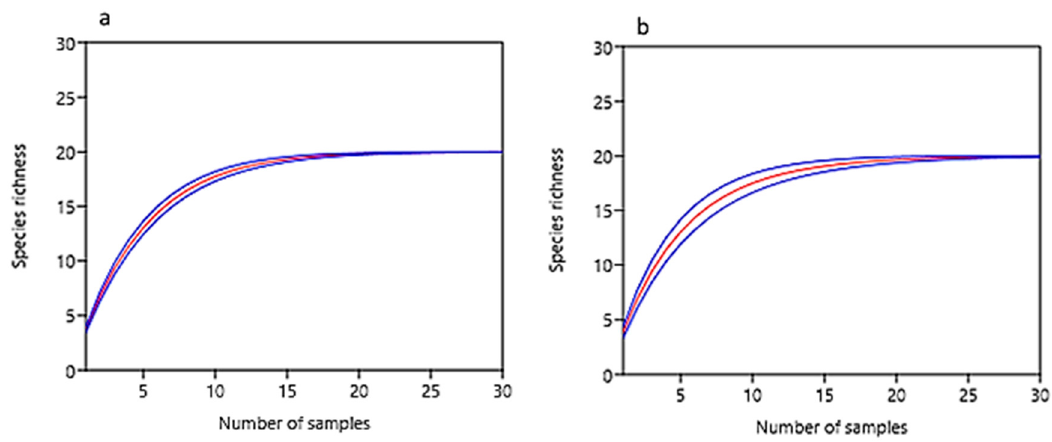
Figure 6. Sample-based rarefaction curves for microfungal communities from ( a ) north-oriented position and ( b ) plain sun-exposed position at the Tabernas Desert (at 95% confidence). Table 2. Diversity characteristics of soil microfungal communities ( R —number of species, including sterile strains, H —Shannon index, J —evenness) in different crust types and bare surface at the Tabernas Desert. Means with the same letter are not significantly different (a one-way ANOVA, the Fisher test, at the 5% level).